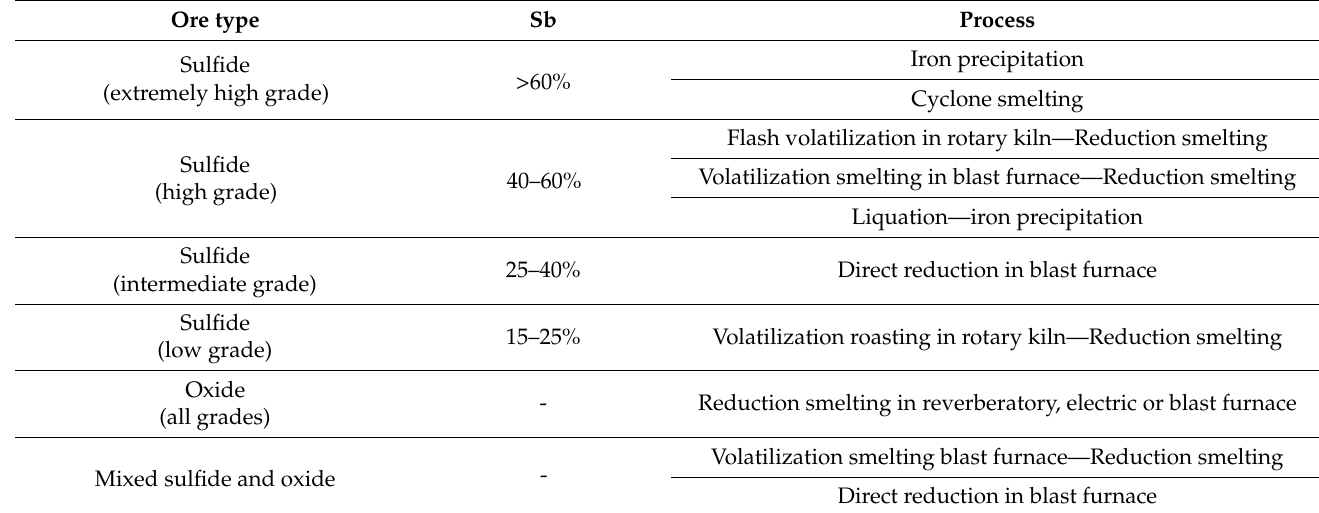
Table 9. Established methods for treatment of different ore types and grades of